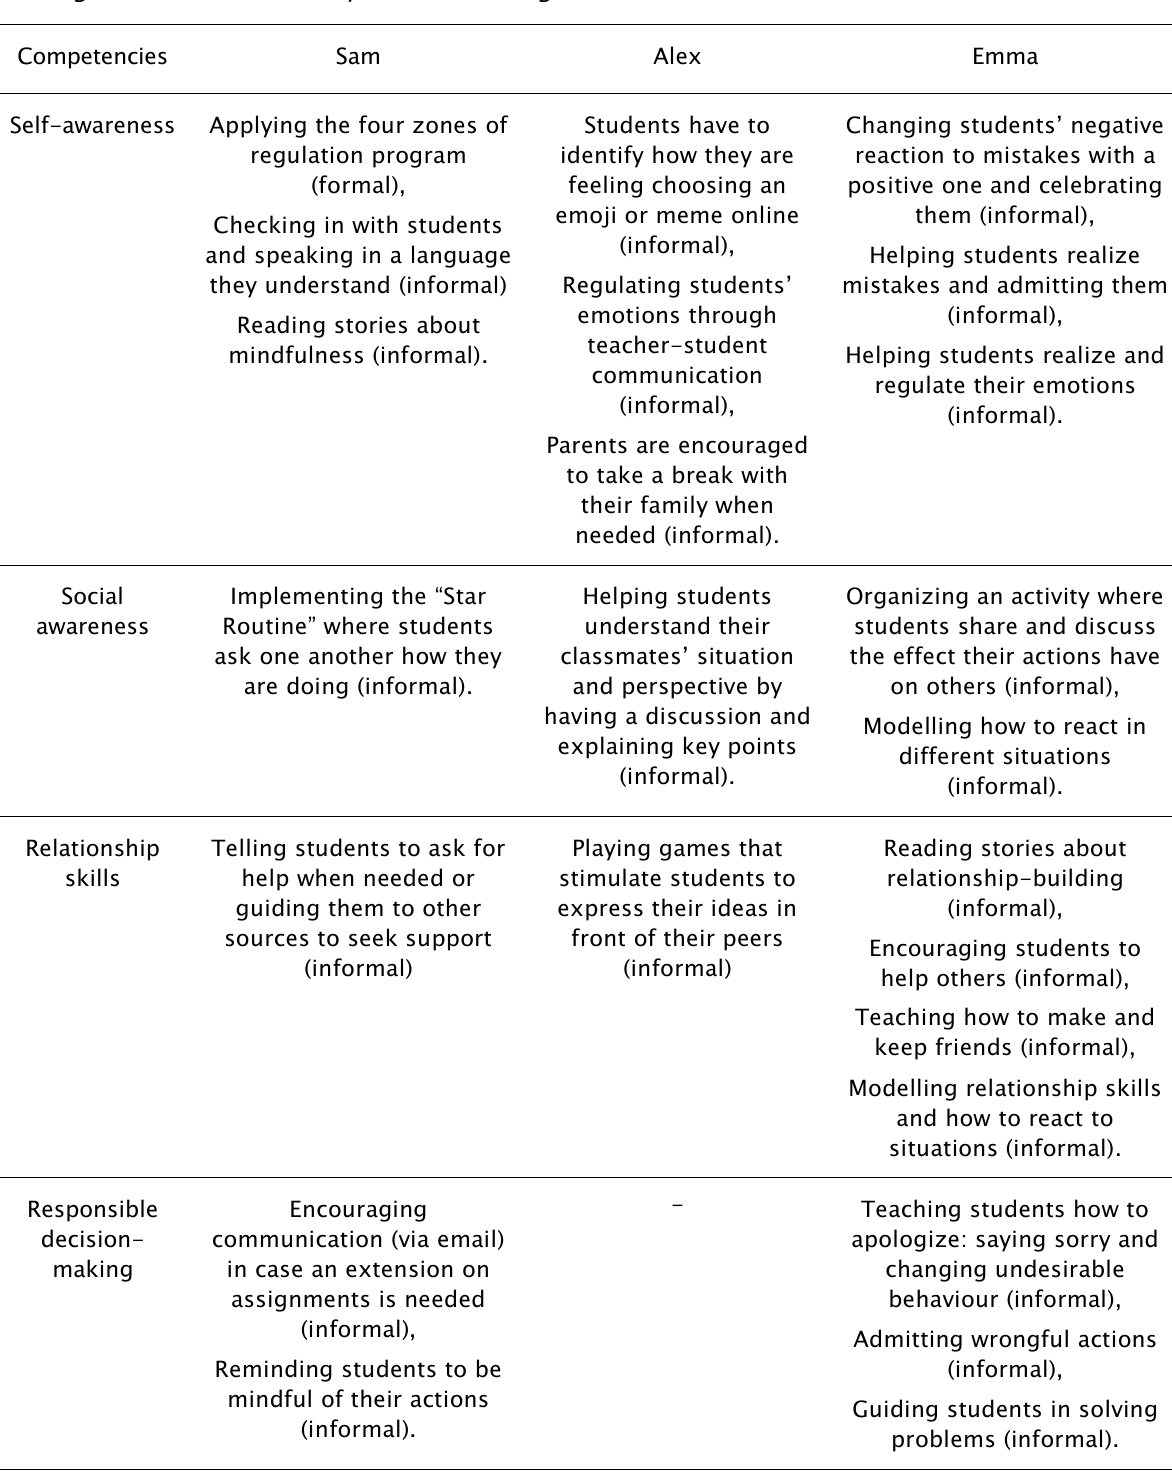
Table 3 Strategies to Teach SEL Competencies During COVID-19